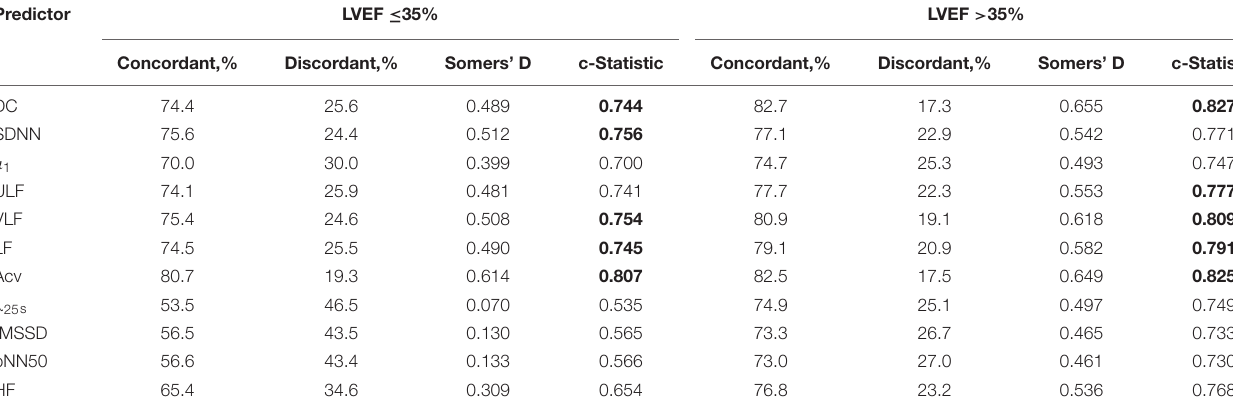
TABLE 3 | Predictive power of HRV and HR dynamics indices for post-AMI mortality (logistic regression analysis). Predictor LVEF ≤ 35% LVEF > 35%